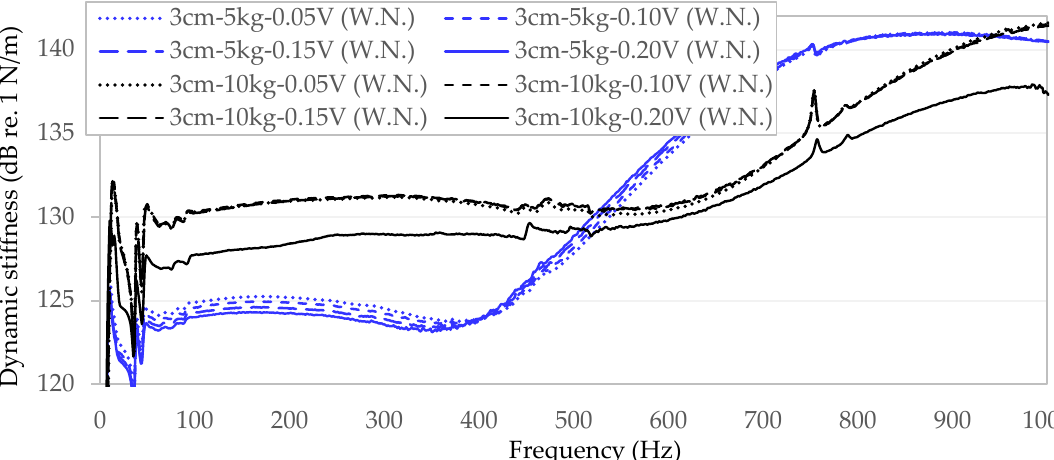
Figure 4. Dynamic stiffness over frequency for samples E1 considering varying static load level and vibration amplitudes.